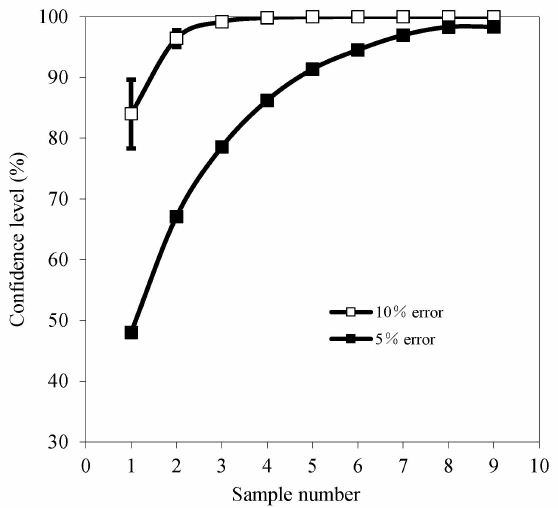
Figure 2. Relationships between the sample number and the confidence level at the 2 m scale at REs of 5% and 10%.